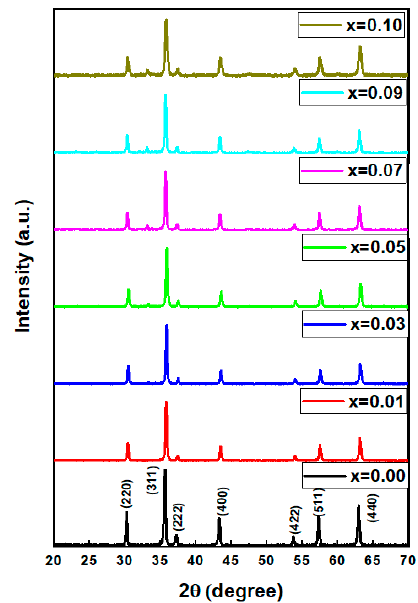
Figure 1. X-ray diffraction ( XRD) powder patterns of prepared nanoparticles (NPs). Figure 1. X-ray di ff raction (XRD) powder patterns of prepared nanoparticles Table 1. Structural parameters of studied NiDy x Fe 2 − x O 4 NPs.